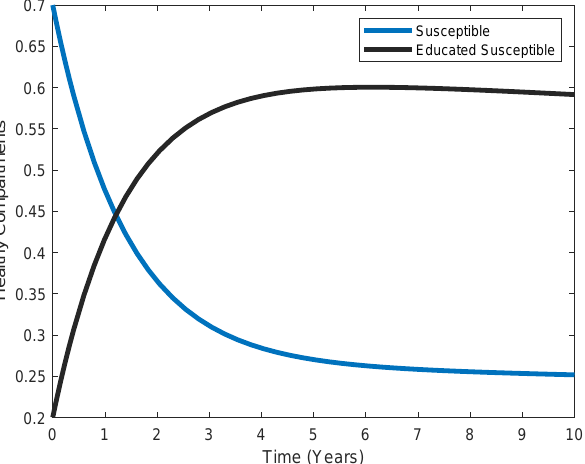
Figure 4. Simulations of system (23) showing the behaviour of susceptible and educated susceptible. Parameters used are Λ = 450,862, β = 0.86, ν = 0.25, φ = 0.2, σ = 0.65, z = 0.11, µ = 0.02041, ψ = 0.5, η 1 = 0.02, η 2 = 0.02, γ 1 = 0.5, γ 2 = 0.6, κ 1 = 0.03, κ 2 = 0.3, δ 1 = 0.2, δ 2 =